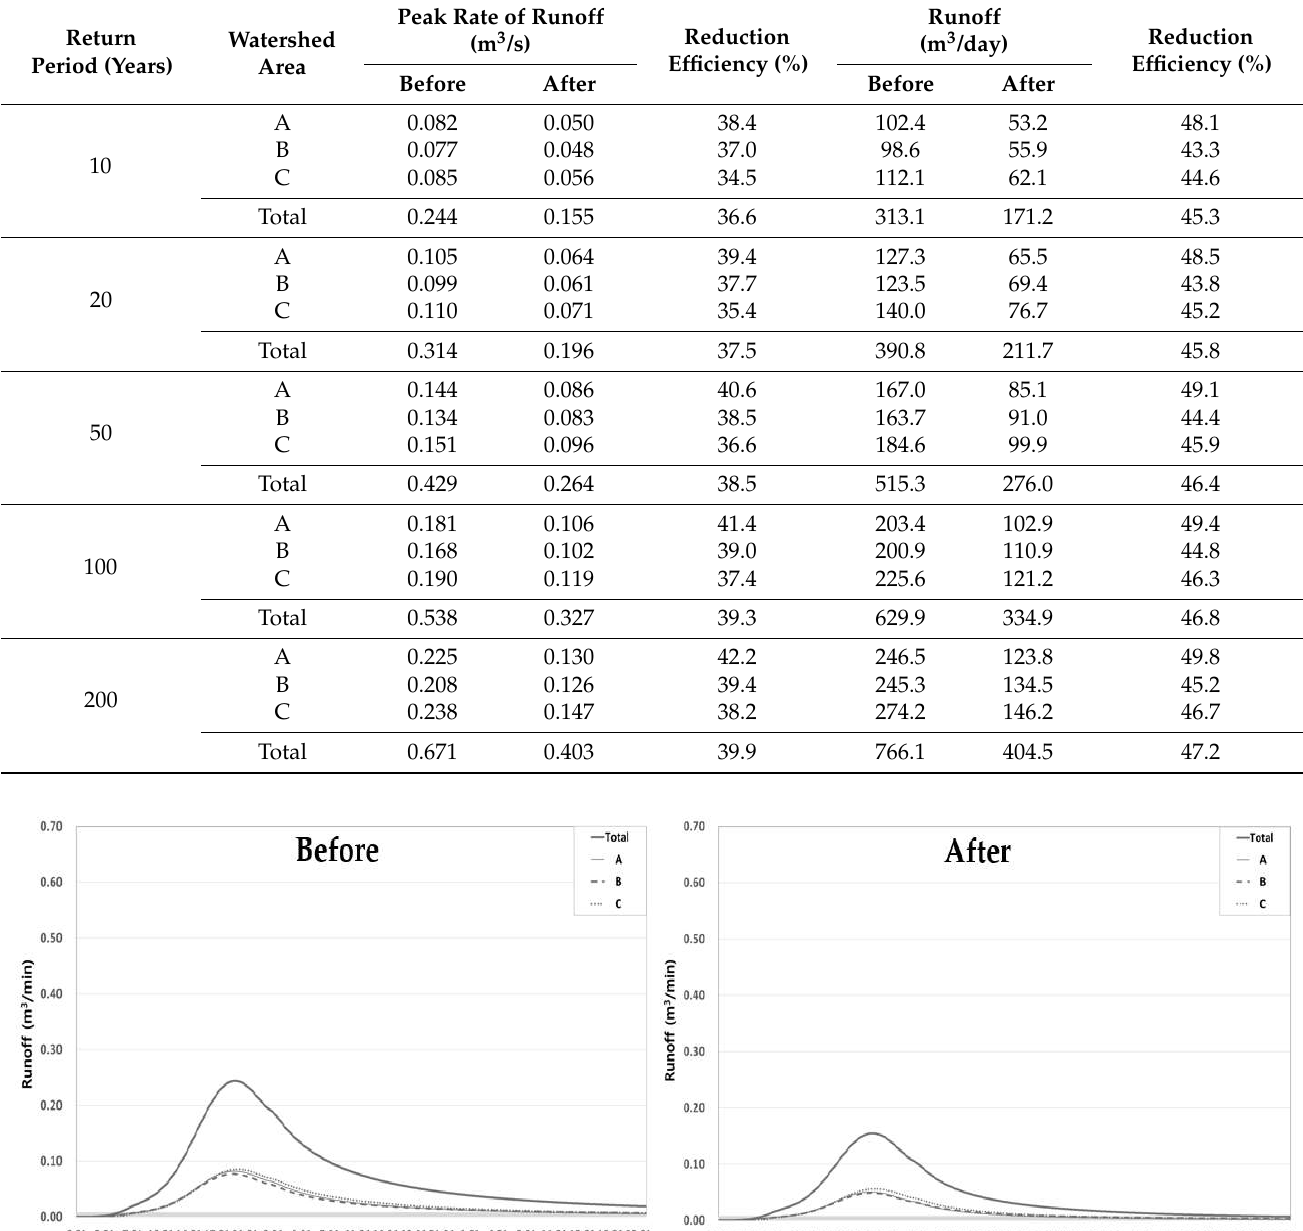
Table 11. Runoff and reduction rate by return period of maximum daily rainfall (RCP 8.5, 1988–2100).